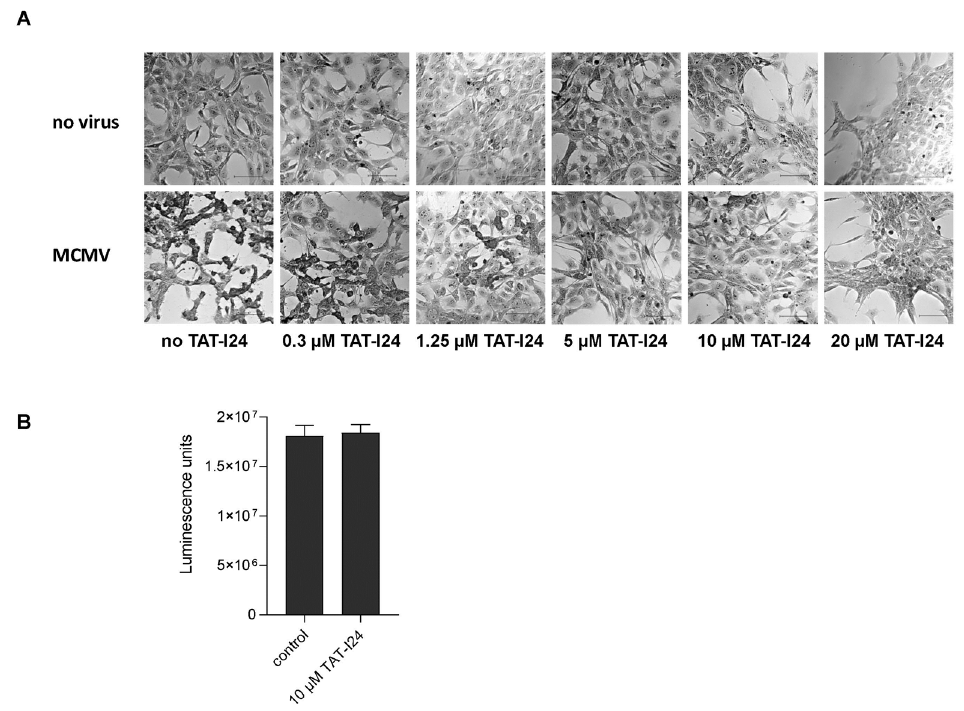
Figure 1. Crystal violet staining of uninfected NIH/3T3 cells and cells infected with MCMV (MOI 1) in the presence of increasing concentrations of TAT-I24 48 h post-infection (Differential Interference Contrast (DIC); 20 × objective). Scale bars indicate 100 µm ( A ). Viability of vehicle-treated cells (control) and cells treated with 10 µ M TAT-I24 for 48 h. Results shown are mean ± standard deviation of eight replicates per group ( B